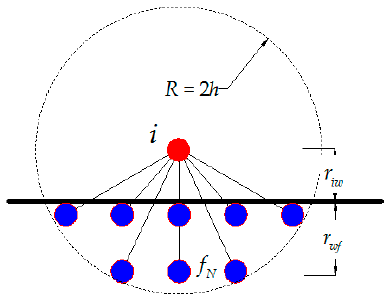
Figure 2. Fictitious particles generation mechanism of the local uniform stencil method for a fluid particle near the wall boundary.